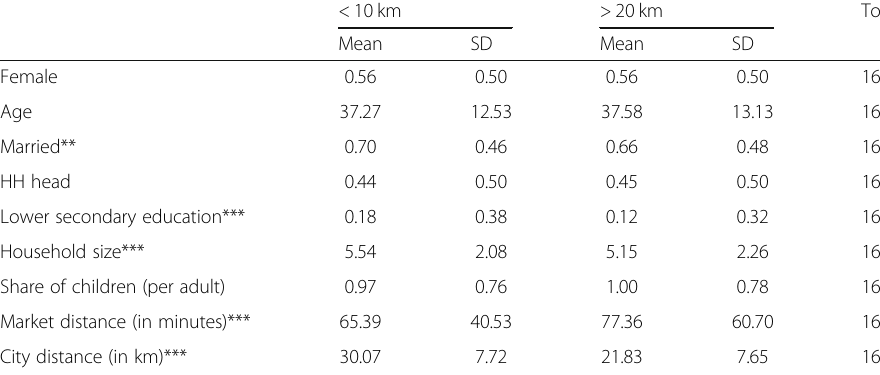
Table 4 Descriptive statistics of covariates (for working age individuals) < 10 km > 20 km Total Mean SD Mean SD Female 0.56 0.50 0.56 0.50 1632 Age 37.27 12.53 37.58 13.13 0.70 0.46 0.44 0.18 5.54 0.97 65.39 40.53 77.36 30.07 7.72